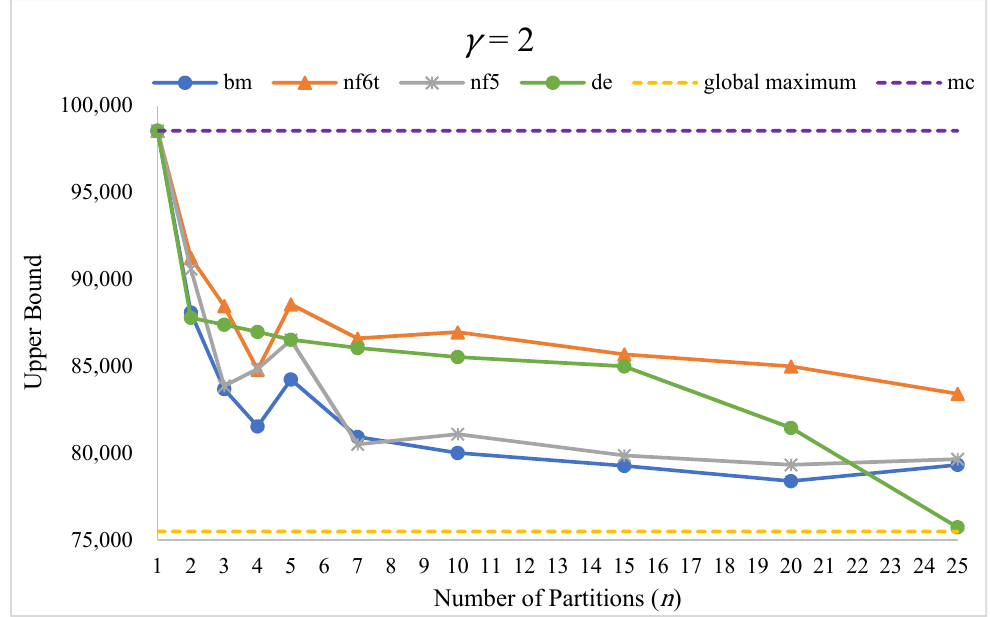
Figure 8. Convergence-indicating curves of the bm , de , nf5 , and nf6t relaxation schemes for 𝛾 = 2.